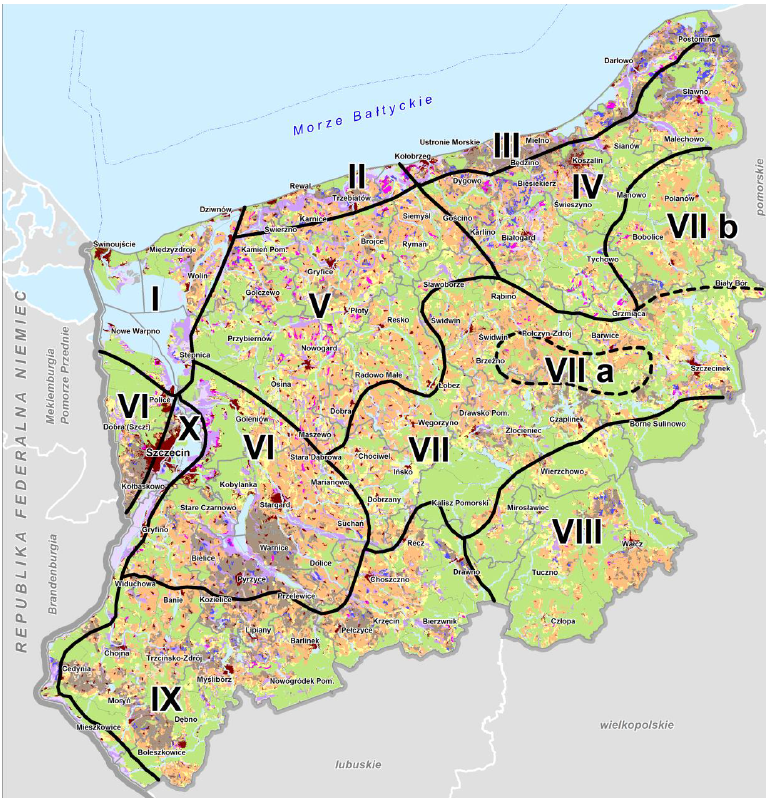
Figure 1. Climatic land map of Szczecin (VI and X) on the map of climatic lands (I–X) and sub– lands (VII a, VII b) of the West Pomeranian Province , Source: Spatial Development Plan for West Pomeranian Province Volume I. The conditions for shaping the spatial policy of the province of